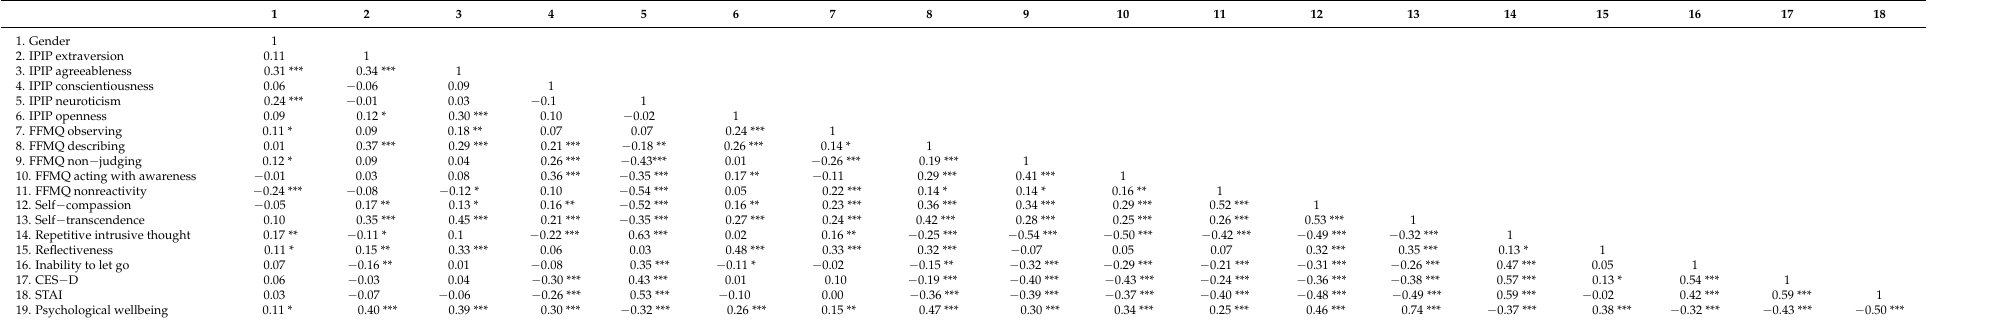
Table 3. Correlations between variables of interest for the regression analyses in Sample